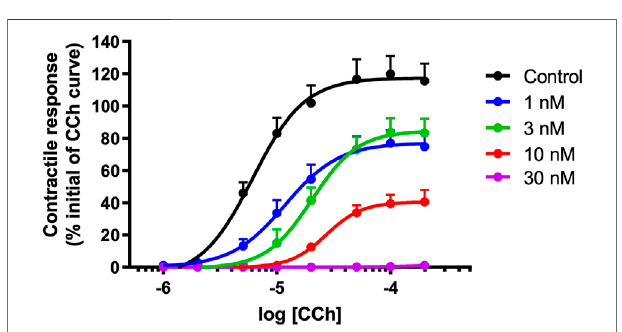
FIGURE 8 | Concentration-dependent effects of α -elapitoxin-Oh3a (1 – 30 nM; n = 5) on cumulative concentration-response curves to carbachol (CCh) in the unstimulated chick biventer cervicis nerve-muscle preparation.